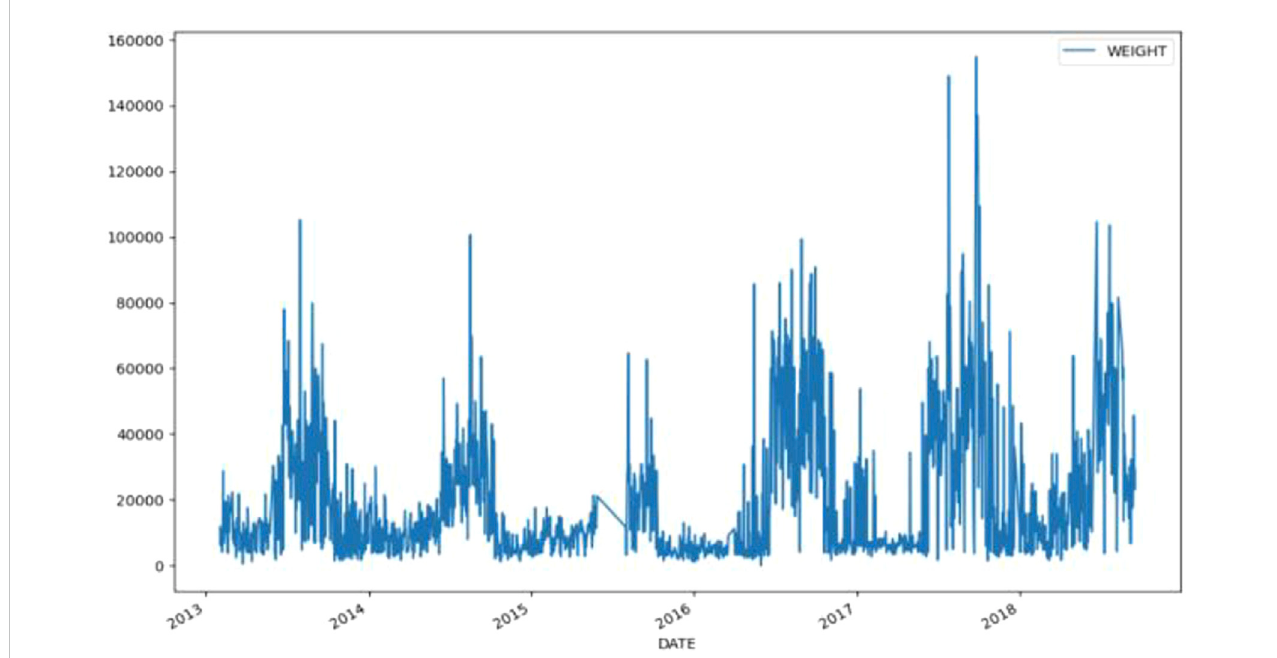
FIGURE 6 Quantum of waste generated at Case study beach from 2013 to 2017 from 2013 to 2018.